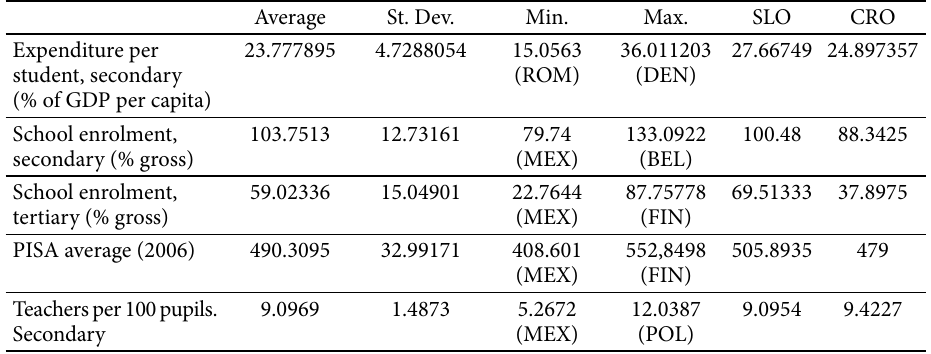
Table 2. Summary